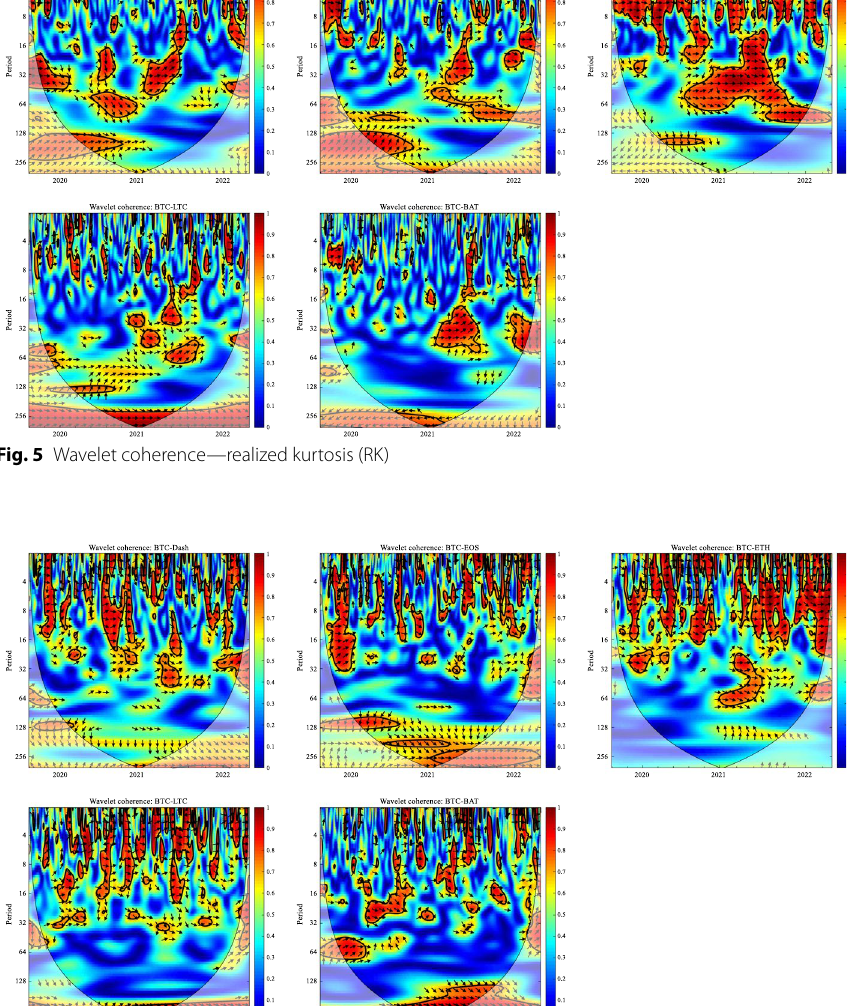
the time horizons. The strength of the dependence is measured by the color bar on the right side of the figures, that is, the red (blue) region represents the high (low) comovement. For robustness, we mainly focus on the significant region (5% signifi- cance level) in black contours. The phase difference represented by directional arrows in the significant regions is used to identify the lead-lag relationships between cryp- tocurrencies. Accordingly, the right (left) direction of the arrows denotes the positive (negative) dependence. The right up or left down direction denotes that BTC leads other cryptocurrencies while the left up or right down direction indicates that other cryptocurrencies lead BTC.